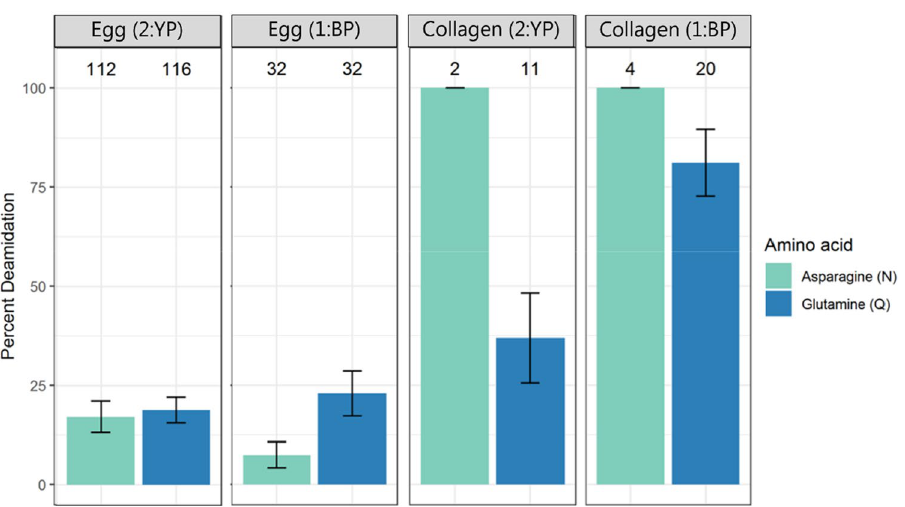
Figure 3. Percentage of deamidation of asparagine (N) and glutamine (Q) residues in egg proteins and collagen for the samples 1:BP and 2:YP. Error bars indicate standard deviation around 1000 bootstrap replicates. Sample identifier and protein class are shown at the very top, while the number of peptides used for the calculation is indicated above each